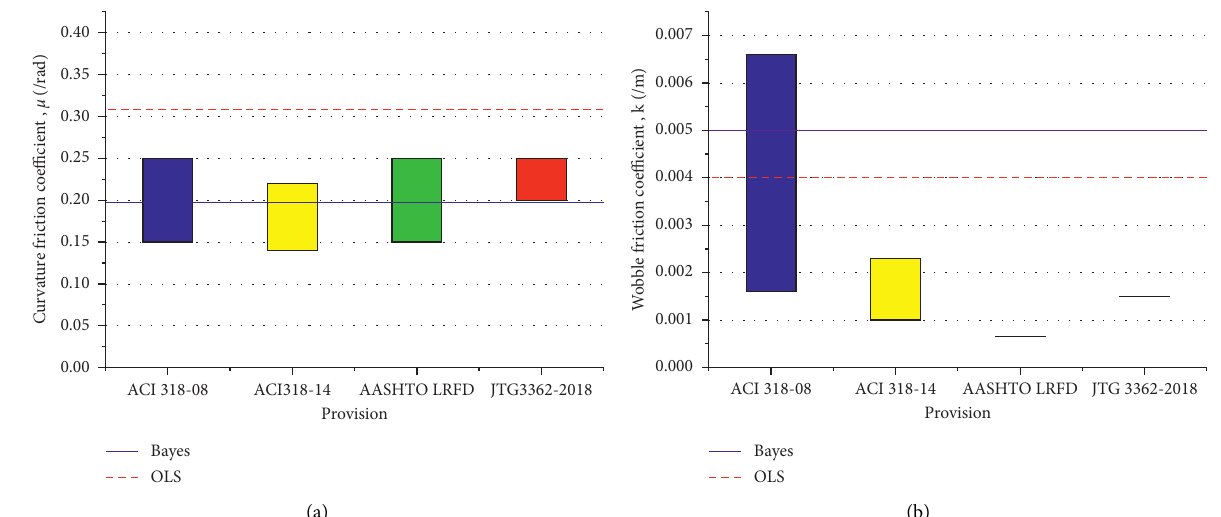
Figure 9: Comparison of range of friction coefficients: (a) curvature friction coefficient ( µ ) and (b) wobble friction coefficient (k). The histograms represent the recommended parameter value ranges given in the Table 5: Parametric hypothesis testing. Bayes estimate